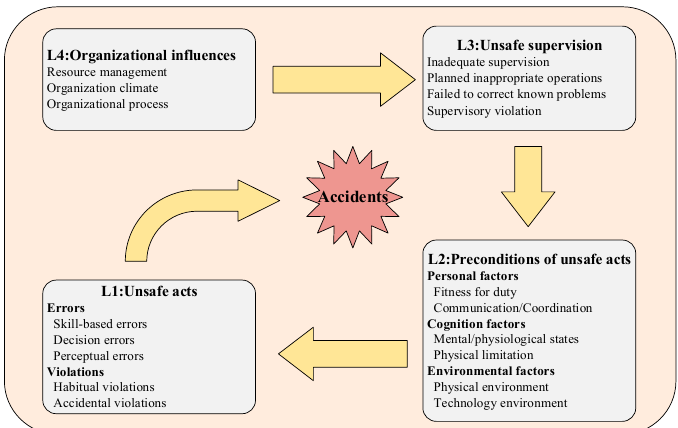
Figure 1. The HFACS framework.